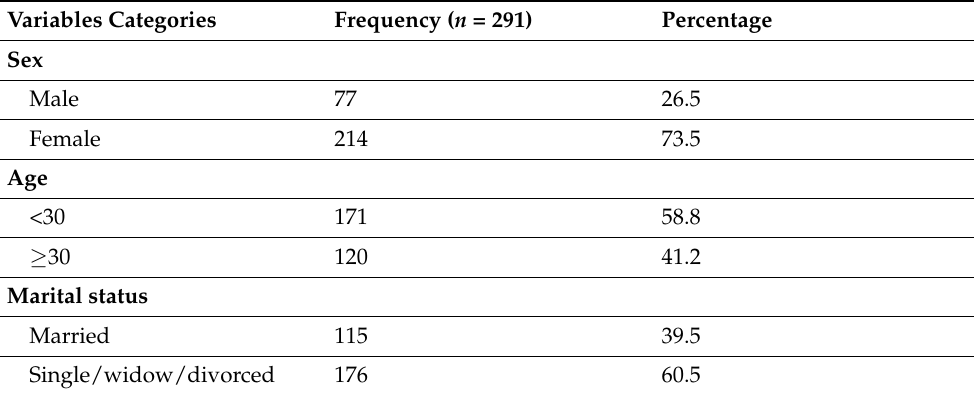
Table 1. Distribution of socio-demographic among integrated textile industry workers, Addis Ababa Ethiopia,